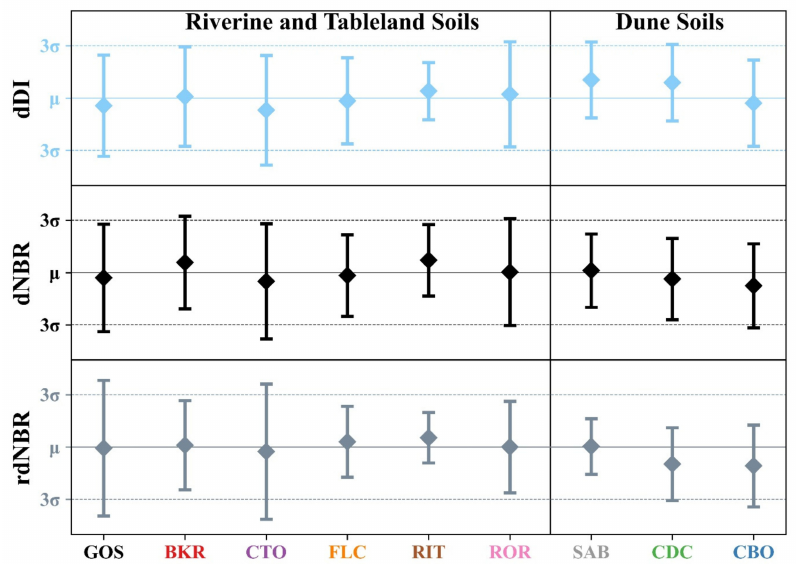
Figure 9. Showing mean ( µ ) and standard deviations ( σ ) of burn indices, differenced Disturbance Index (dDI), differenced Normalised Burn Ration (dNBR) and relative differenced Burn Ration (rdNBR), grouped by Landsystem soil unit. Indices have been thresholded according to dNBR threshold (>0.2), with outliers above 3 STDs removed from individual soil